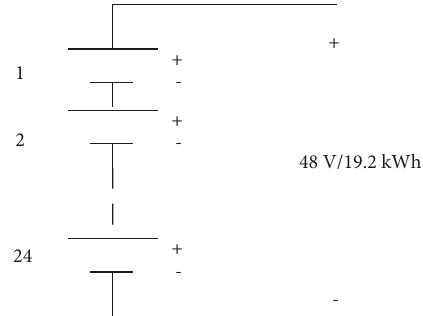
Figure 3: The storage battery block rated at 48 V/800Ah-19.2